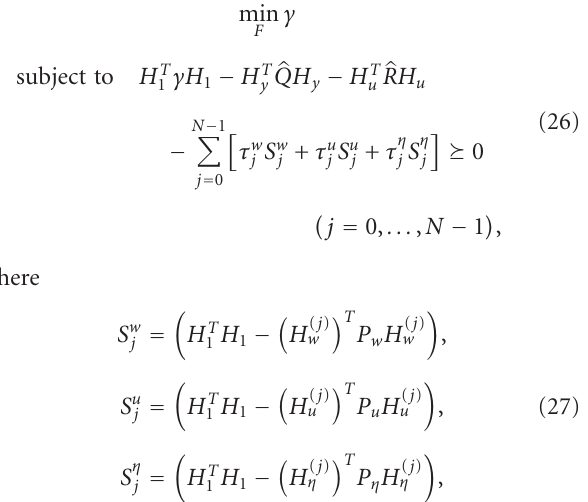
Figure 1: Dividing